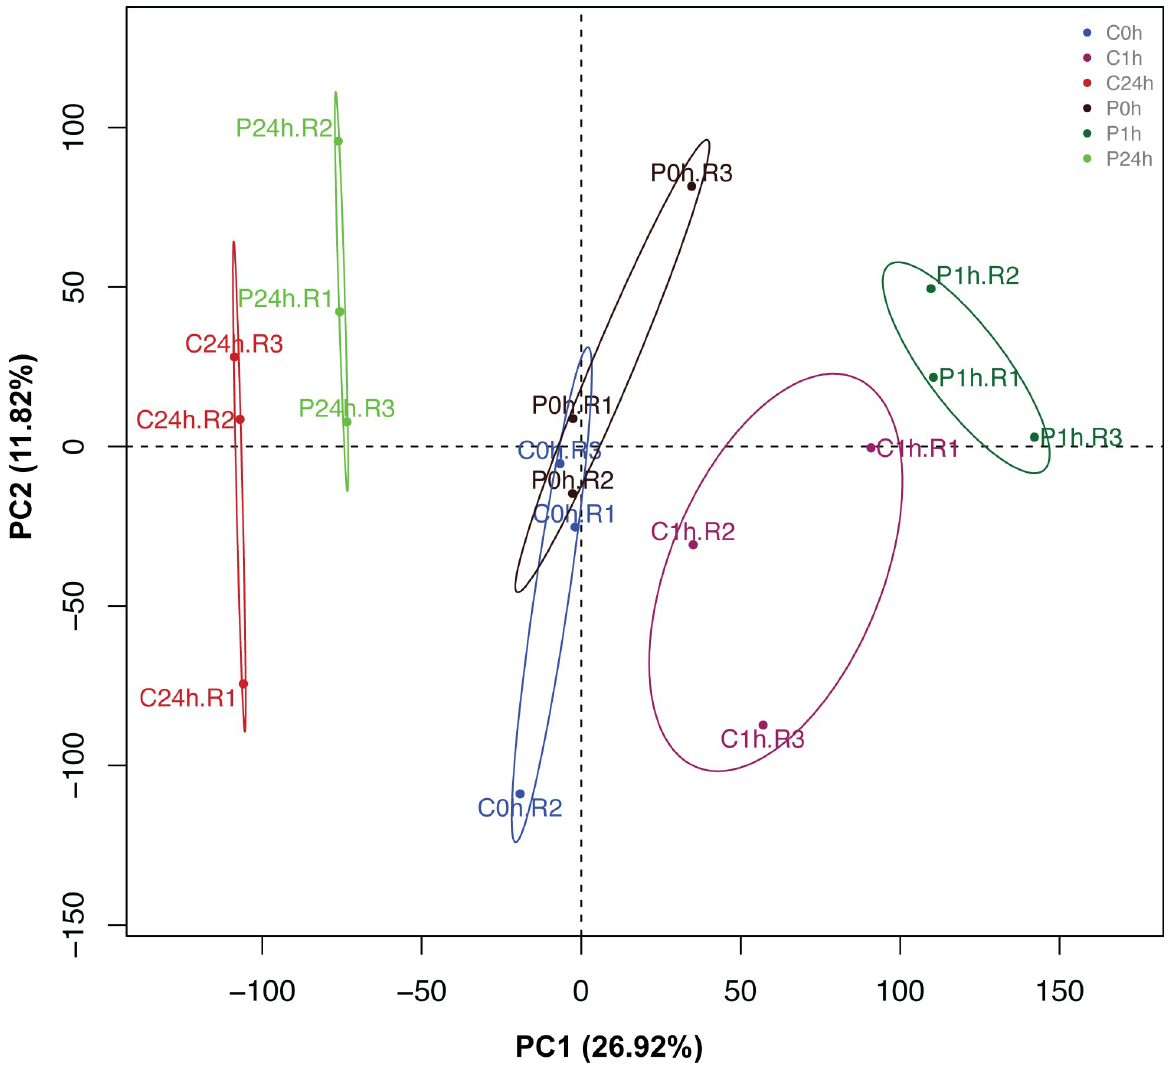
Fig 2. Principal component analysis (PCA) of global gene expression data in Arabidopsis plants inoculated or non-inoculated with Paraburkholderia phytofirmans PsJN before and after the challenge with Pseudomonas syringae DC3000. Colored dots denote each biological replicate. “C” and “P” indicate non-inoculated plants and P . phytofirmans PsJN-inoculated plants, respectively, while the number next to each dot indicates the sampling time. R indicates the replicate number of the Affymetrix